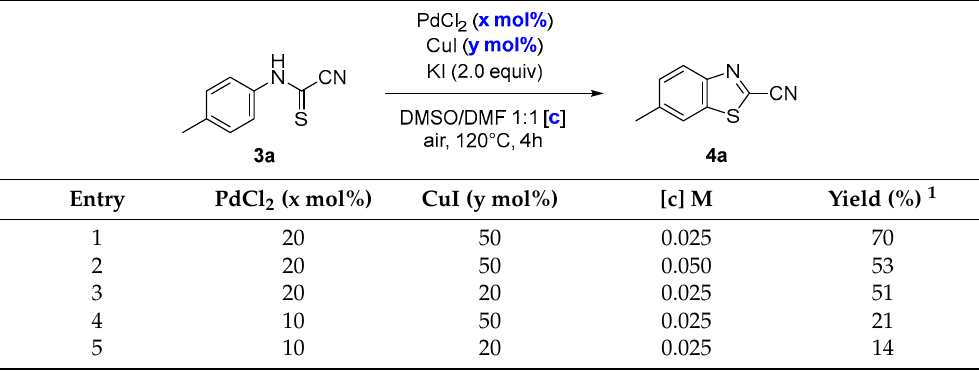
Table 4. Optimization of PdCl 2 and CuI sources as well as starting molar concentration.